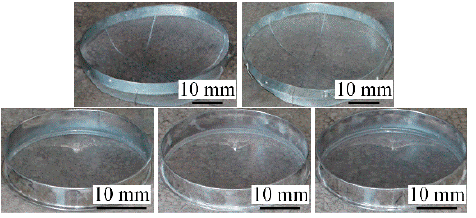
Figure 3. Sieves for screening sand during the test.